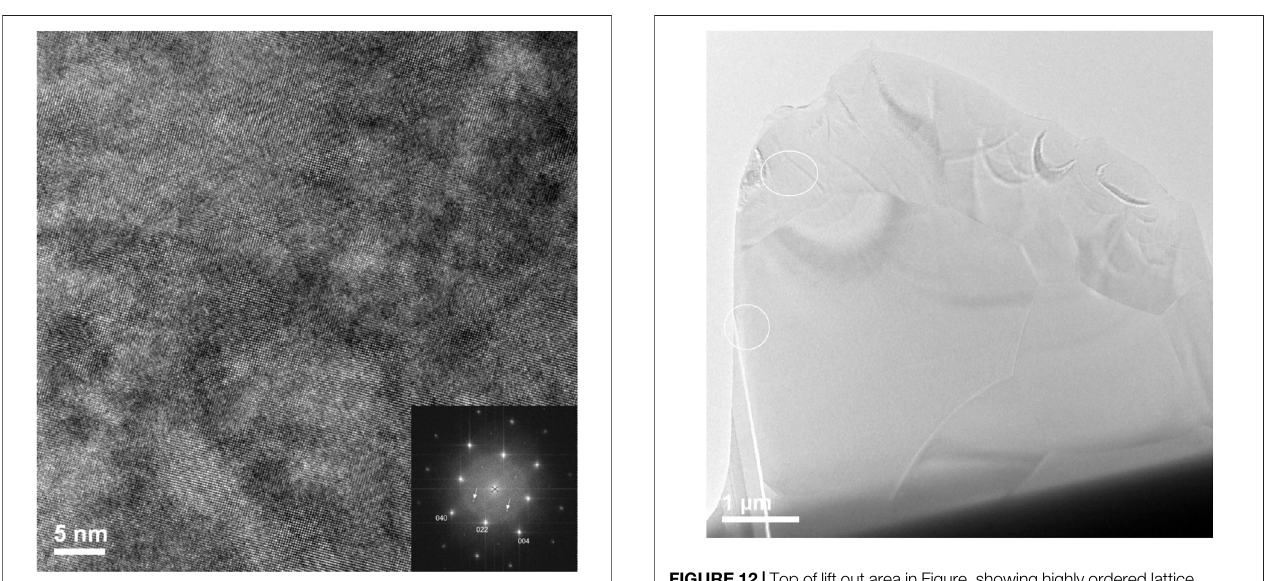
FIGURE 10 | High magni fi cation image of irradiated Nd 2 Zr 2 O 7 area at the top of the lift out of Figure 12 showing no evidence of disorder.